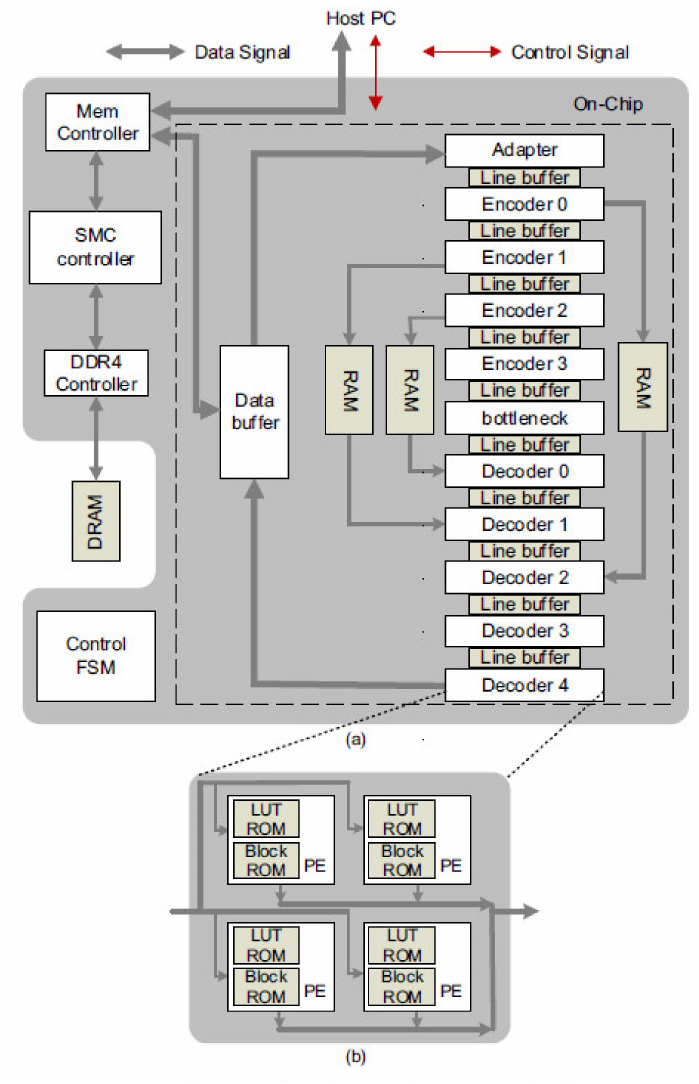
Figure 19. FPGA accelerator hardware framework consisting of AXI master interface, Vivado IPs and processing logic [66]: ( a ) The top-level system is acted as an AXI master to read/write data; Dual-port RAMs are used to store the pooling index; ( b ) The computing-in-memory blocks: the LUT and Block ROMs are used to store weight and BN-Binz reference parameters. Noted that the PE number in different blocks is different (Reprinted with permission from ref. [66]. Copyright 2021